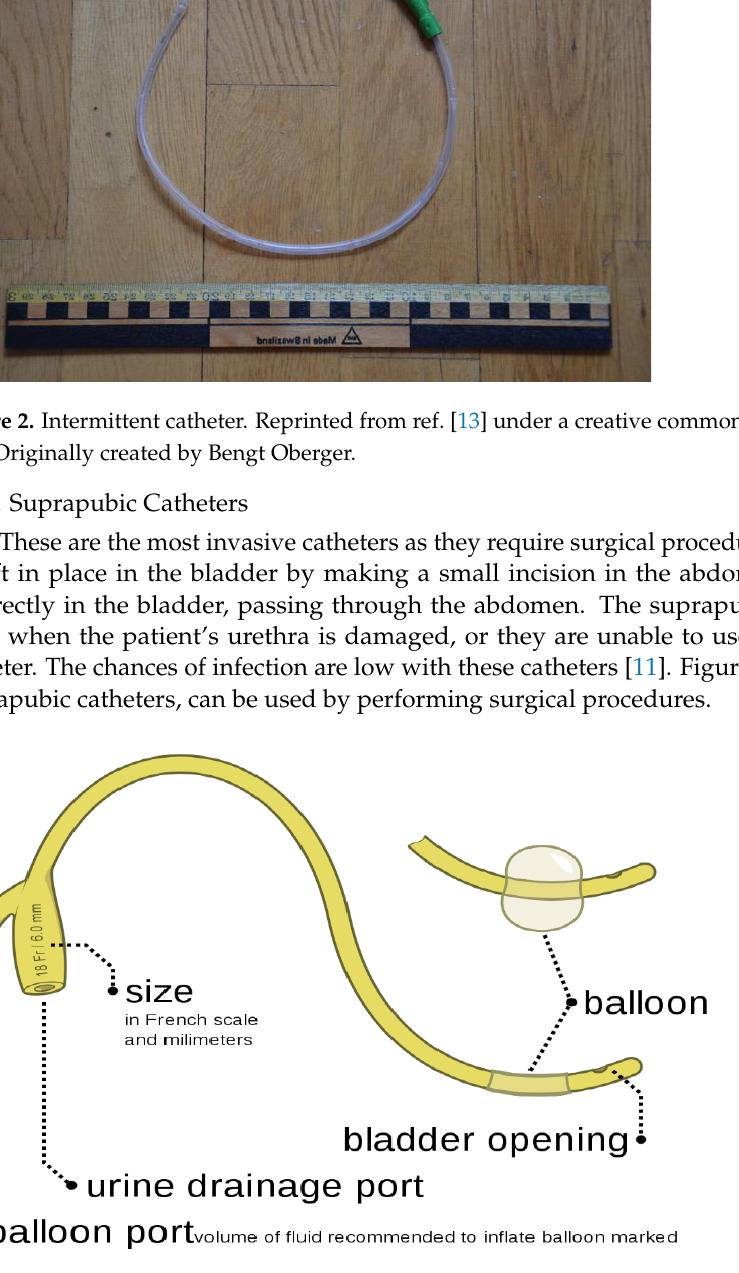
Figure 3. Suprapubic catheter. Reprinted from ref. [14] under a creative common license (CC BY-SA 3.0), Originally created by Olek Remesz.